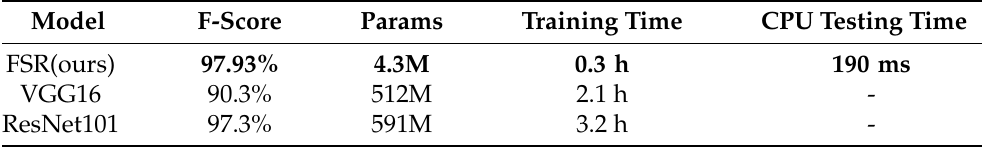
Figure 6. Training and validation loss curve of the model as a function of epochs. Table 1. Focus State Recognition Model based on